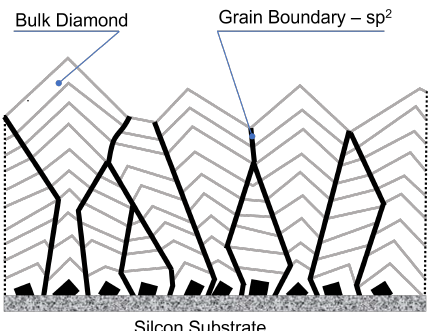
Figure 4. Schematic views on the structure of polycrystalline diamond